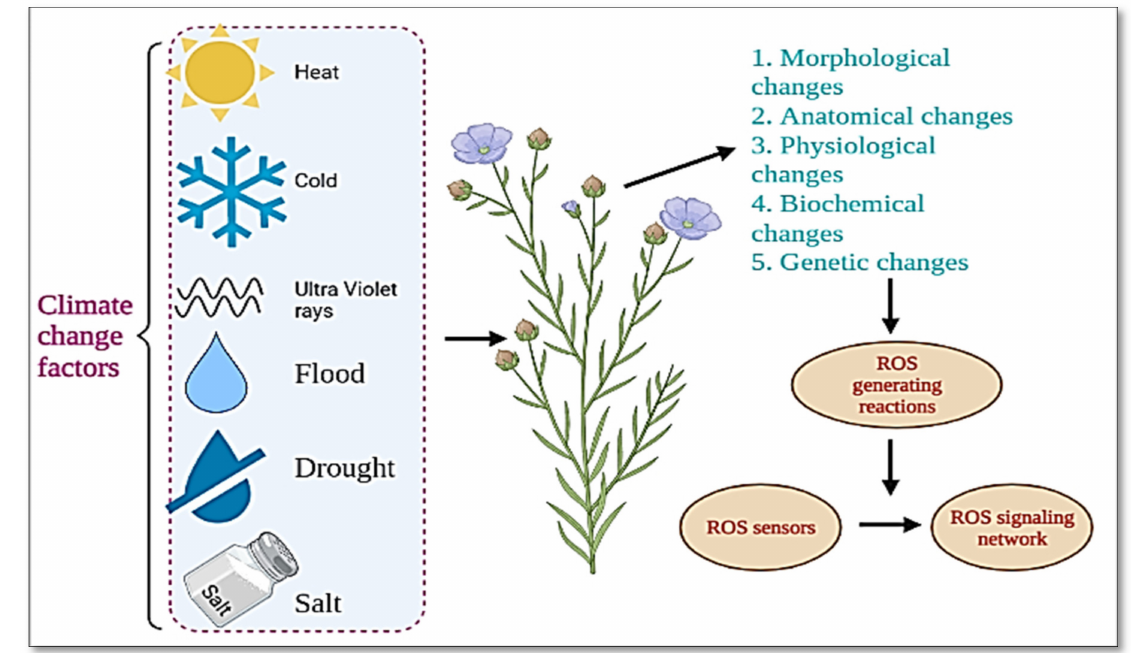
Figure 1. Depicting the effects of climate change (in the form of the different factors, such as heat, cold, ultraviolet rays, flood, drought, and salinity stress) on the medicinal plants resulted in morpho-anatomical and physio–biochemical changes, which further lead to the ROS production. ROS production is sensed by ROS sensors which will activate the ROS signaling network. ROS generation is harmful to the plants, and ROS finally leads to the death of the plants (created with